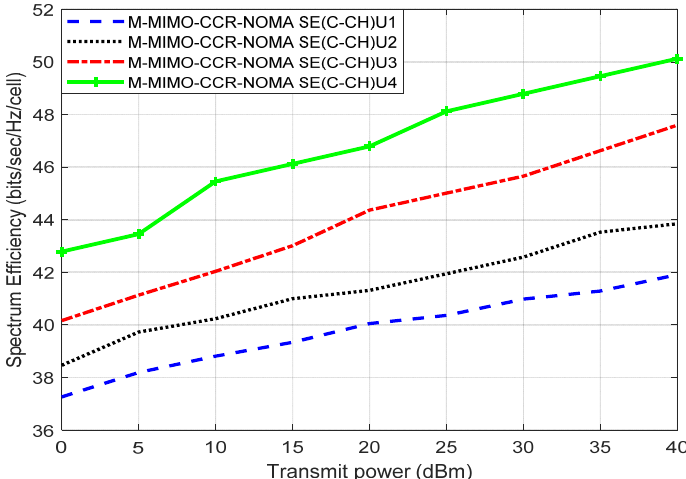
Figure 11. SE against transmitting power for 4 users’ 128 × 128 M-MIMO DL NOMA PD with C-CH CCRN.